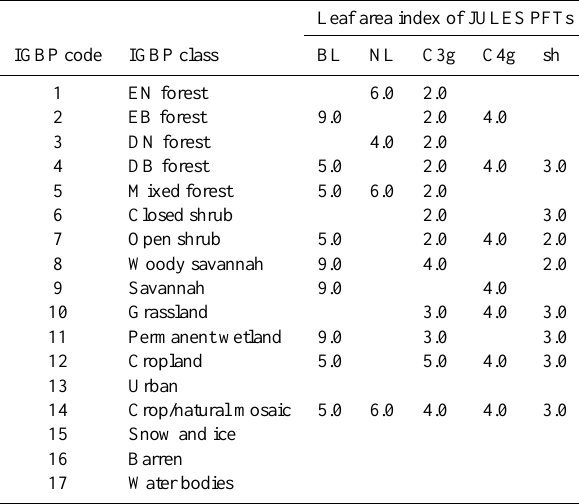
Table A1. Annual maximum leaf area index (LAI) of JULES vege- tation land cover types (PFTs) (BL: broadleaf tree; NL: needleleaf tree; C3g: C3 grass; C4g: C4 grass; sh: shrubs) for each of the 17 IGBP categories. Note that for the snow and ice, barren and water bodies categories, there are no LAI values available.